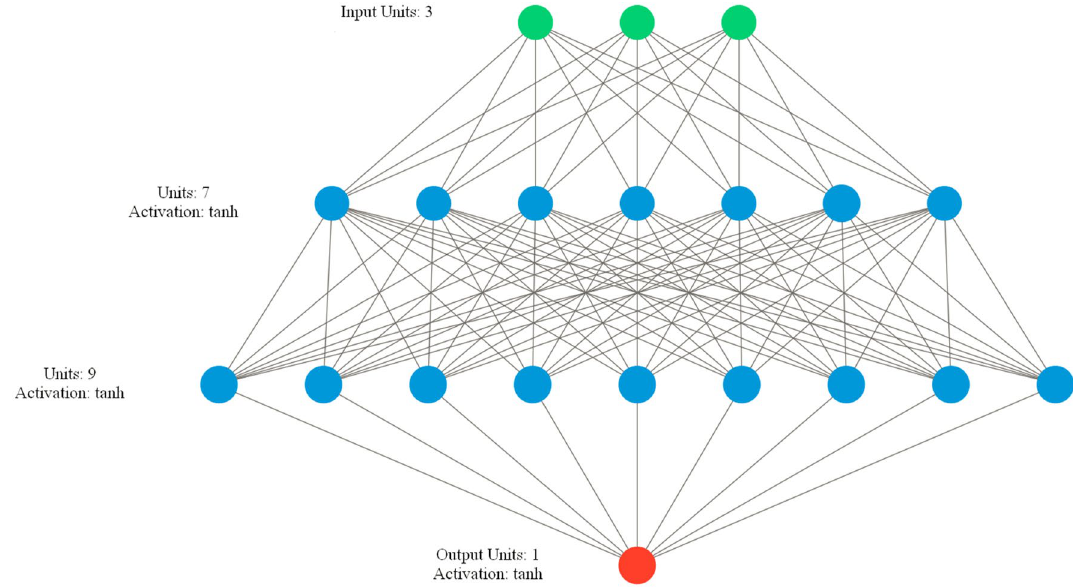
Figure 4. Neural network architecture for the predictive models. The three predictor values are put into the first layer consisting of three input neurons. Then, the computational process continues through the two hidden layers. Finally, mSCL prediction is calculated as the activation of the output neuron.